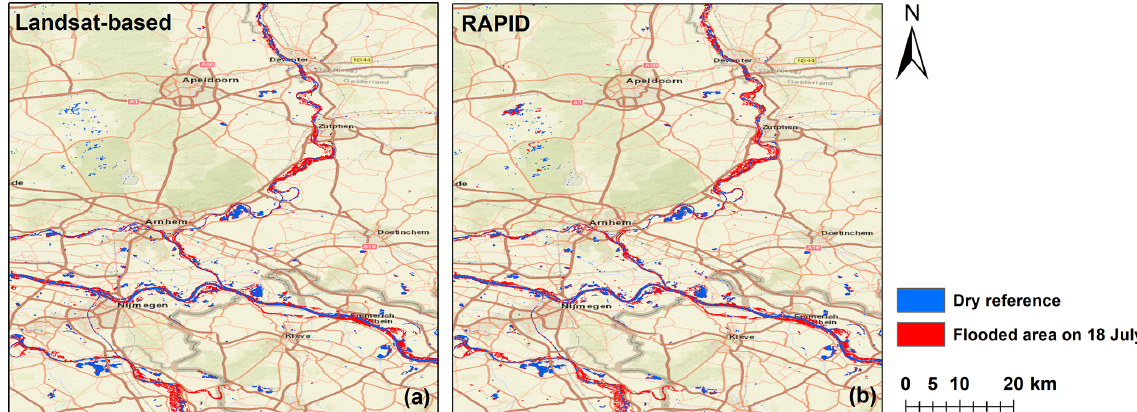
Figure 4. Inundation extent from the (a) Landsat-based flood map and (b) RAPID flood map on 18 July in the central Netherlands. Table 1. Inundated area of land use grouped by countries over western Europe. Inundation area (km 2 ) France Artificial surfaces Agricultural areas 974 Wetlands